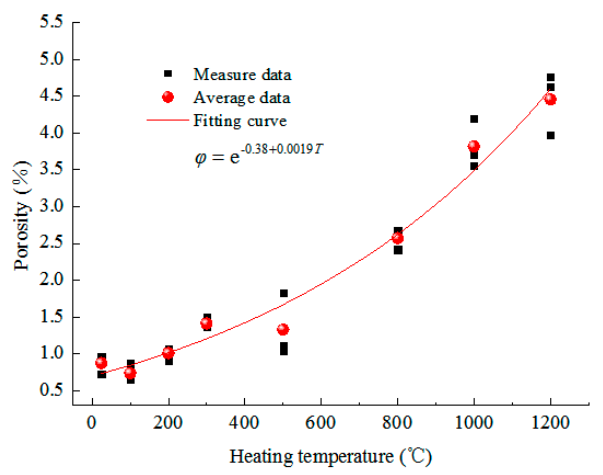
Figure 11. Variation of porosity of the granite samples with increasing temperature.